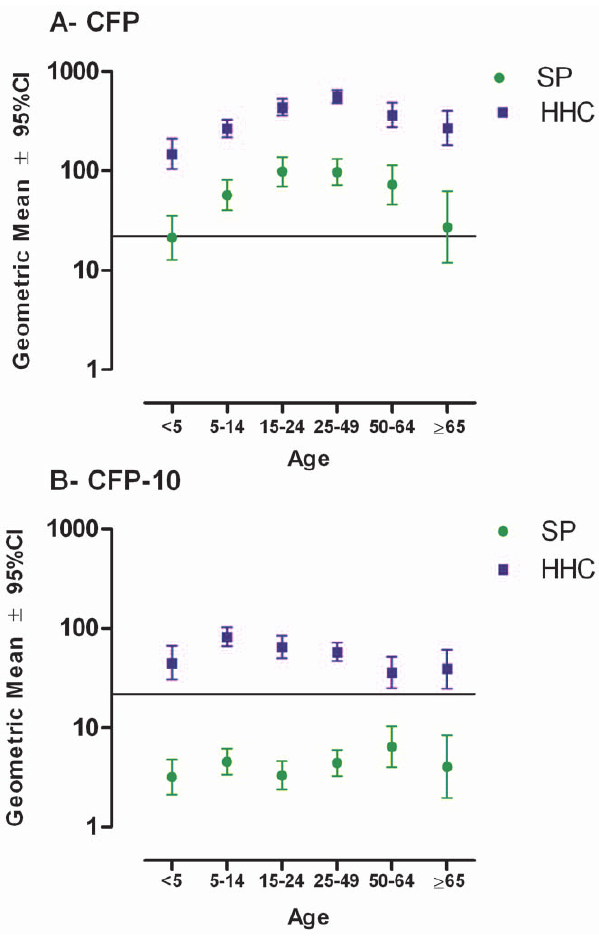
Figure 3. IFN c production levels by age. Geometric means of IFN c production in response to CFP (A) and CFP-10 (B) by age in household contacts (HHCs) and individuals from source population (SP). Horizontal lines depict the cut-off value (22 pg/mL).